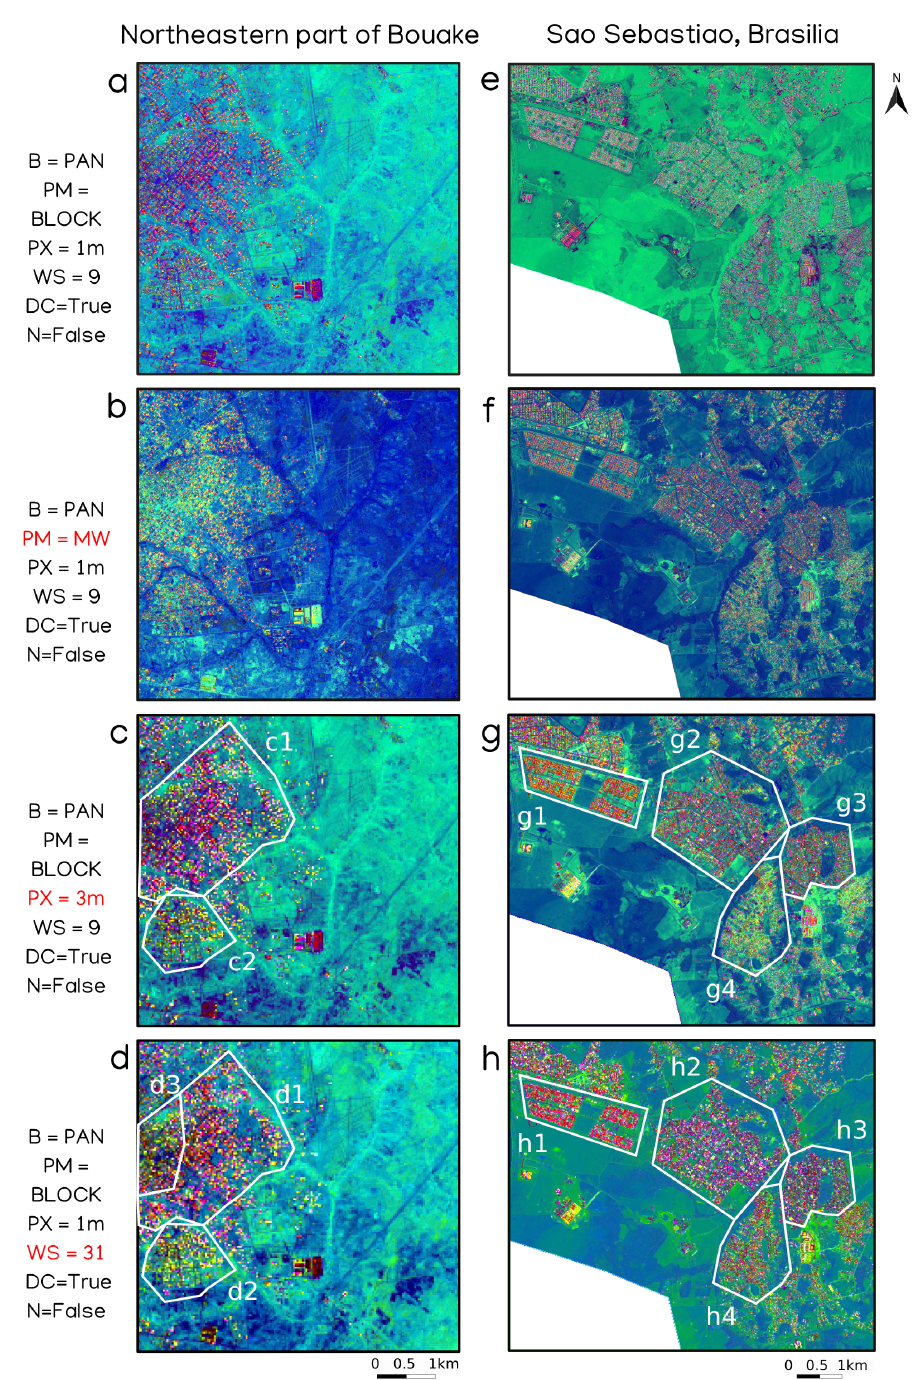
Figure 8. Influence of various parameters (partitioning method, pixel size and window size) in FOTOTEX in the characterization of urban units at the meso-scale from Pleiades images on the northeastern part of Bouake and Sao Sebastiao, Brasilia. ( a , e ) use of block method, ( b , f ) use of moving window method, ( c , g ) use of a 3 m input pixel size over, ( d , h ) use of a window size of 31 pixels. The text in red highlights the modified parameter compared with image ( a ). (PX = pixel size, WS = window size, PM = partitioning method, MW = Moving Window, DC = DC component, N =